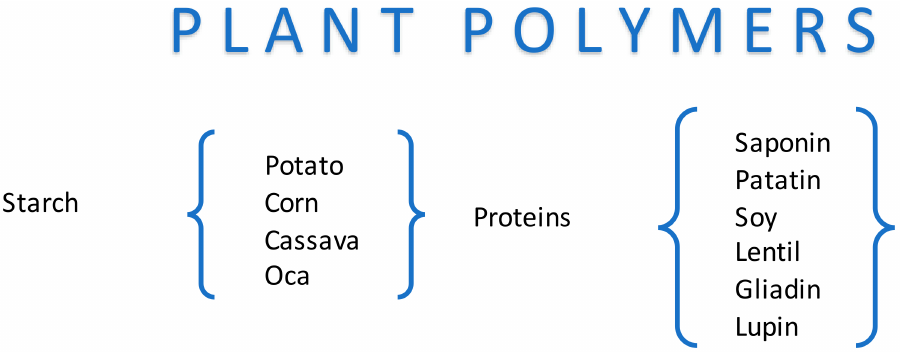
Figure 1. Examples of sources of plant polymers utilized to produce solid foams.